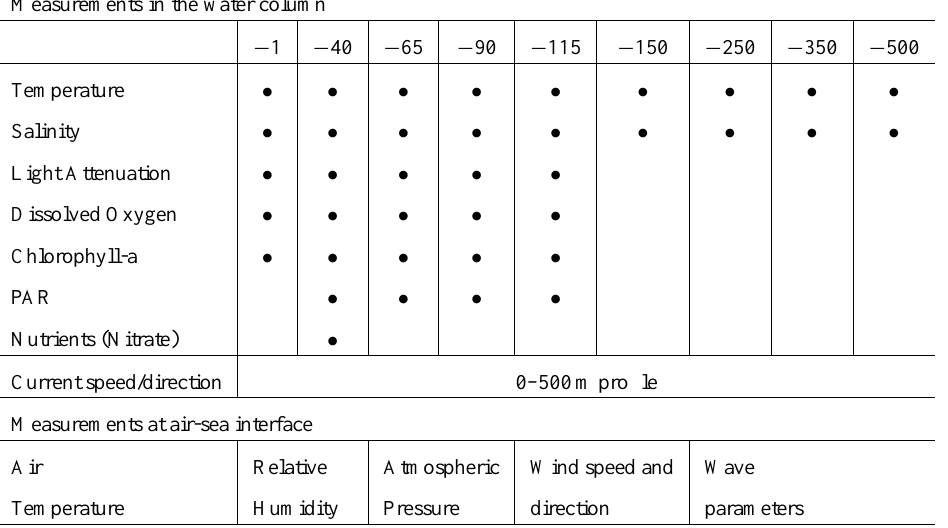
Table 1. List of parameters measured by the M3A system Measurements in the water column −